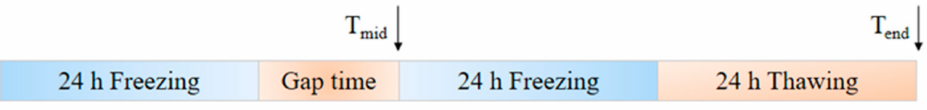
Figure 10. Schematic diagram of the experimental